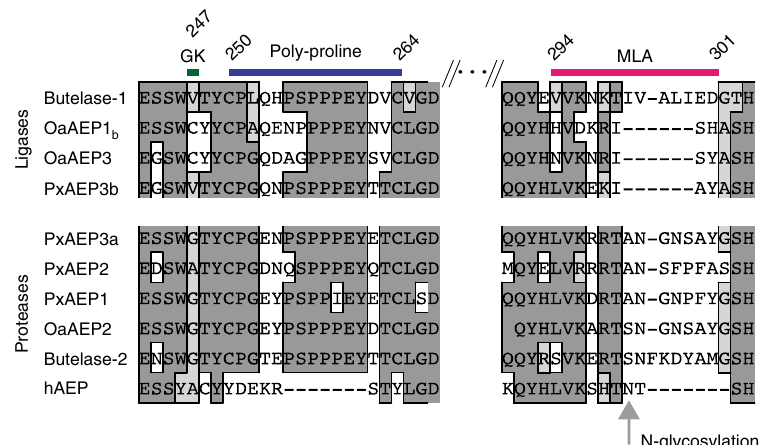
Fig. 3 The marker of ligase activity (MLA) is present in evolutionary distant AEP ligases. Multiple sequence alignment of functionally veri fi ed AEP plant ligases from O. af fi nis , C. ternatea and P . x hybrida with protease-type AEPs from the same plant species. Overlaid by a magenta bar is the region de fi ned as the marker of ligase activity (MLA), which contains a deletion in the functionally veri fi ed ligases from petunia (PxAEP3b) and O. af fi nis (OaAEP1 b and OaAEP3) and is rich in hydrophobic residues in the case of the butelase-1 from C. ternatea . For human AEP (hAEP), a glycosylation site is present within a similarly small MLA region 28 . Overlaid by a green bar is the Gatekeeper (GK) residue (Cys247, OaAEP1 b numbering) identi fi ed in OaAEP1 to be important for its in vitro ligase ef fi ciency 22 . Overlaid in blue is the plant-speci fi c poly-proline loop, which is present in both plant ligase and protease type AEPs but missing from the human AEP